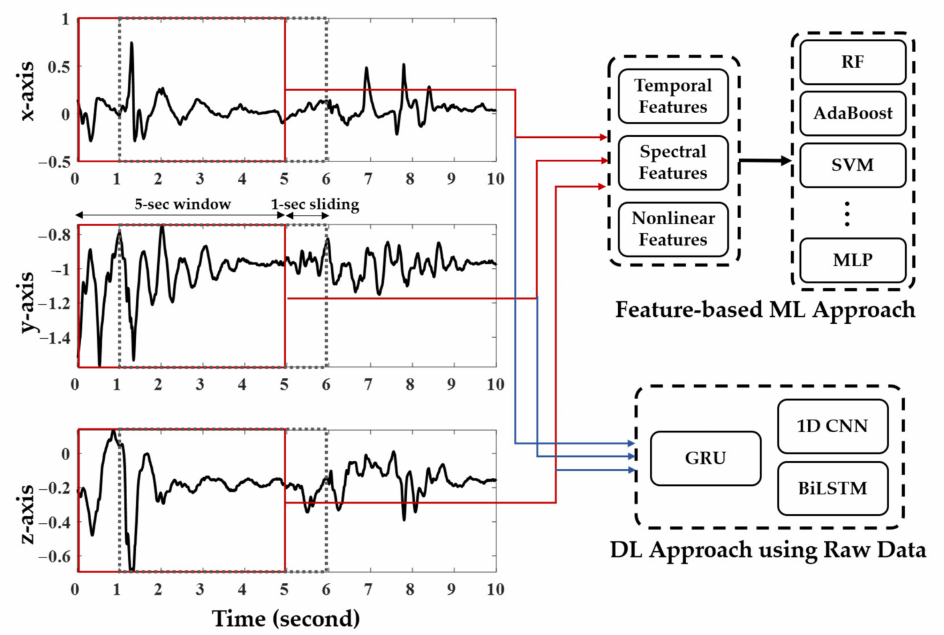
Figure 3. A 5-s window with a 4-s overlap was used to extract temporal, spectral, and nonlinear fea- tures, respectively. These features were used to construct 10 machine learning methods, including the ensemble approach. Four deep learning methods utilized raw data itself without feature